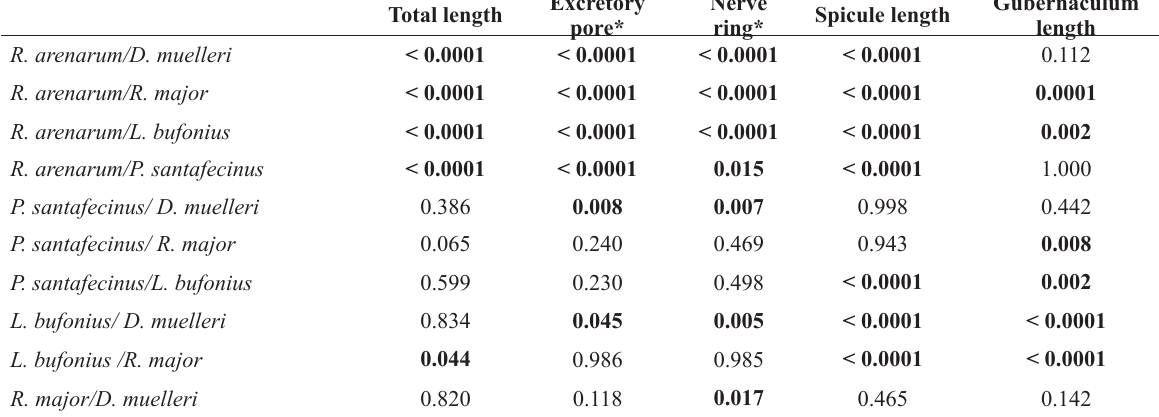
P values for pair comparisons of morphological features of males of A. hylambatis from different amphibian hosts in Argentina. Significant values in